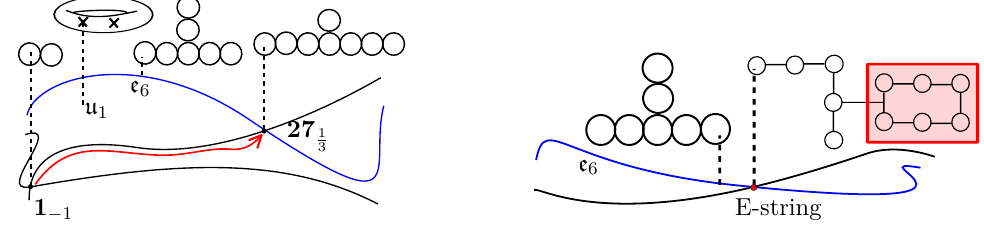
Figure 3 . Two ( E 6 × U(1)) / Z 3 geometries and the superconformal transition where an 1 1 singlet is tuned onto a 27 1 locus which merges the local su 2 and e 7 enhancement into a non-flat fiber. 3 for the concrete three-fold Y in detail. A schematic depiction of the fiber properties is 3 ,b shown in figure 3. There the non-flat surface component is highlighted as a red box as well as its reducible components. In the example one observes these reducible components to arrange in a closed loop that is attached to other fibral divisors [2, 16, 17]. Computing